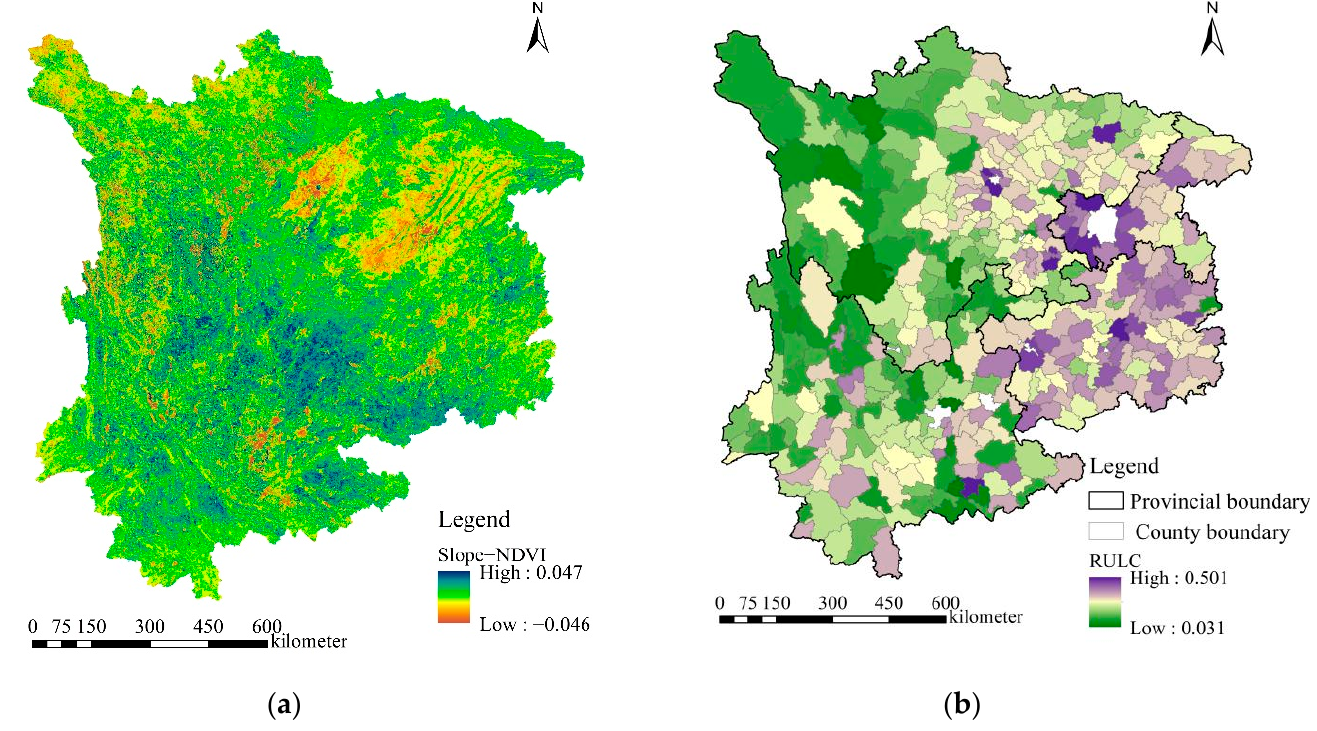
Figure 5. ( a ) Vegetation changes in the mountainous areas of southwest China from 2000 to 2015; ( b ) The RULC trend from 2000 to 2015 in the mountainous area of southwest China.